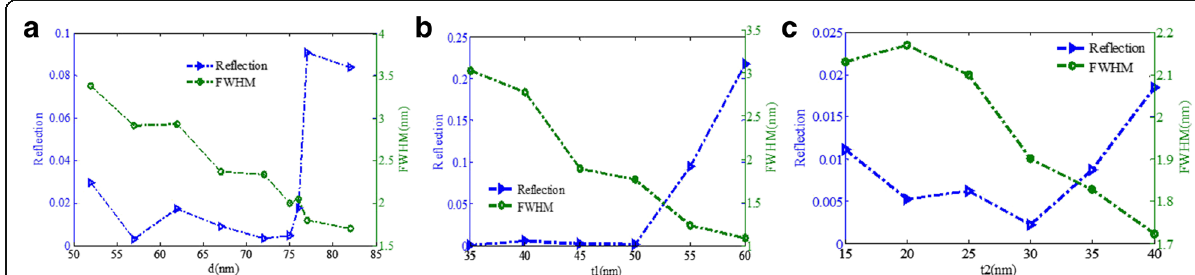
Fig. 9 a Reflectivity dip and FWHM as functions of the triangular gold nanoribbon width d . b Reflectivity dip and FWHM as functions of the gold nanoribbons thickness t 1 . c Reflectivity of the resonance dip and FWHM as functions of the triangular gold height t